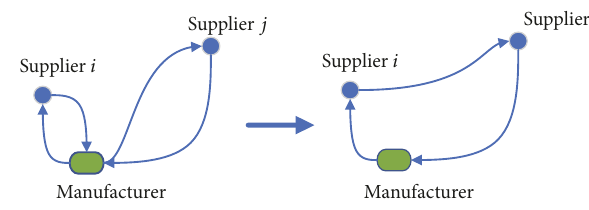
Figure 2: Changes in vehicle pickup